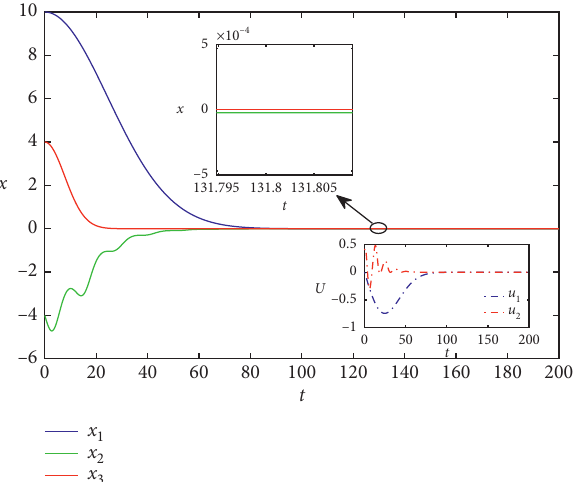
Figure 4: Simulation results of states and control inputs for system